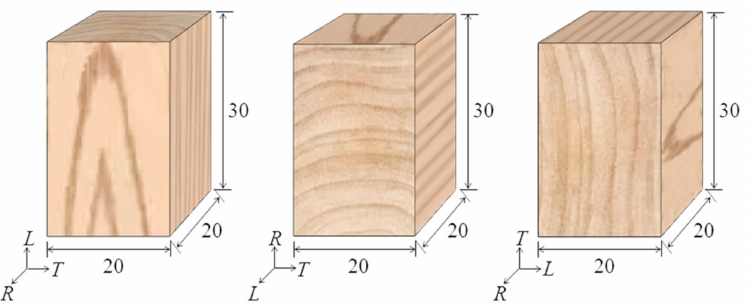
Figure 1. Schematic diagram of the